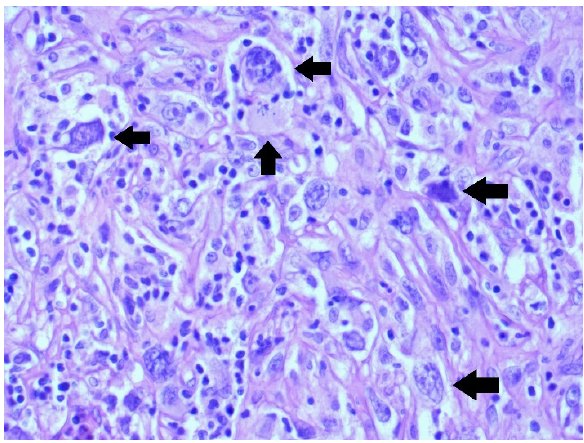
Figure 4. Pleomorphic tumour cells with enlarged round to bizarre nuclei—side arrow; atypical mitotic figure—up arrow (H&E staining, 400×).